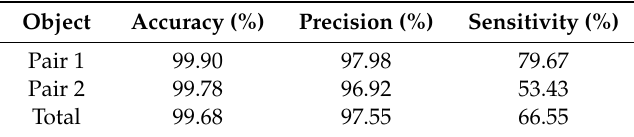
Table 5. Recognition accuracy and precision at point cloud level.